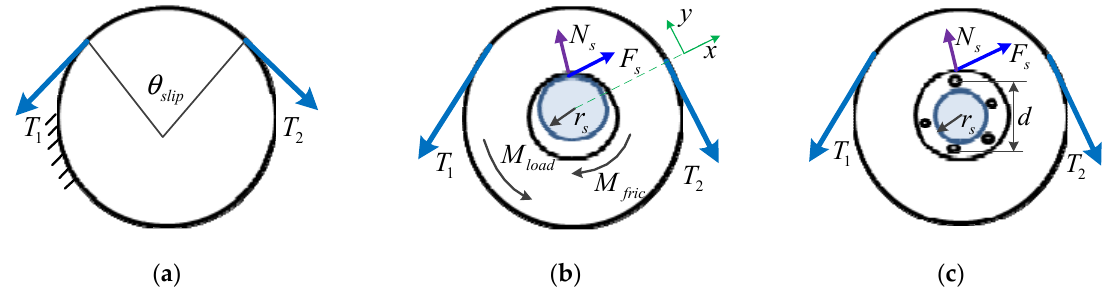
Figure 4. Free-body diagram of pulleys with three supporting forms: ( a ) Pulley fixed to the base; ( b ) Pulley supported on the shaft; ( c ) Pulley supported on the rolling bearing.